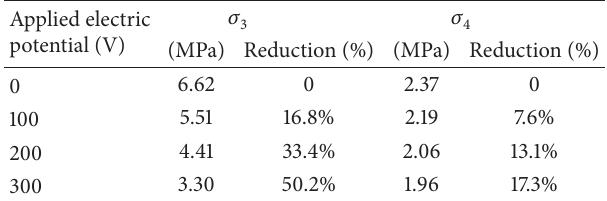
Table 2: Comparison of peak stresses for cross ply